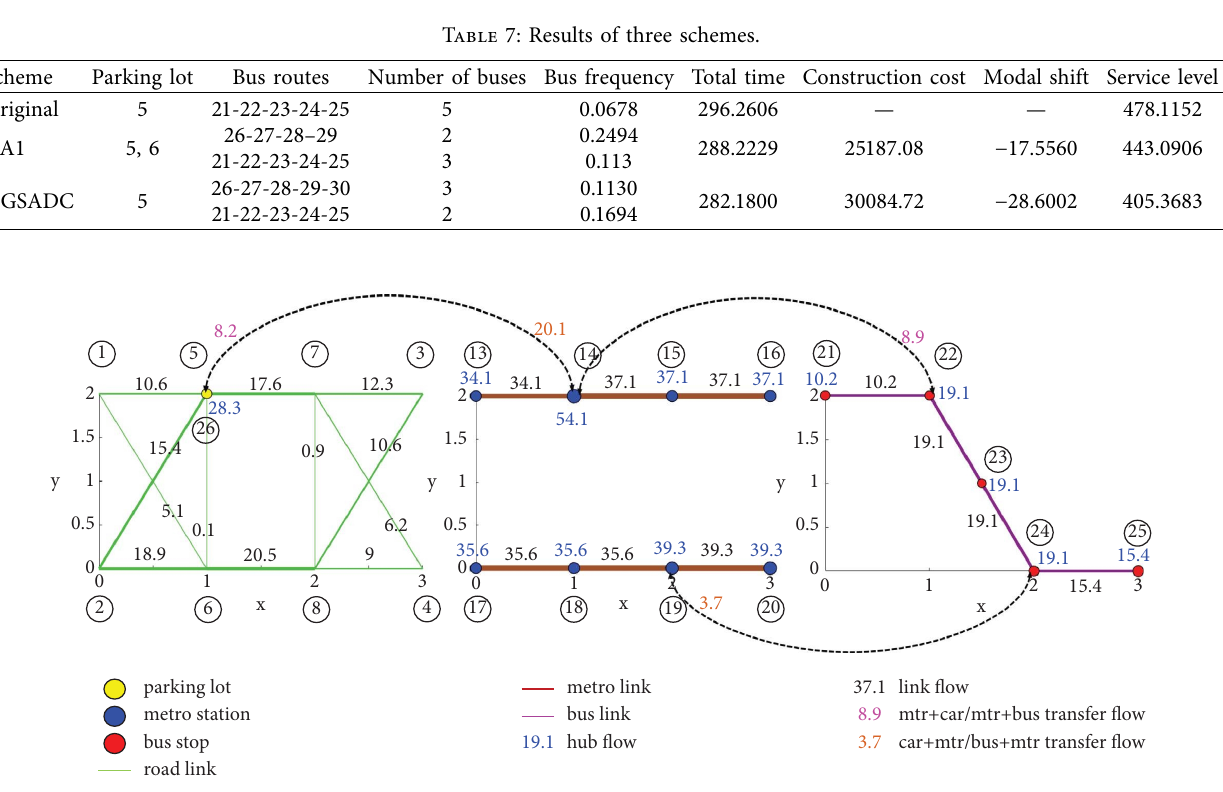
Figure 8: Flow distribution of the original